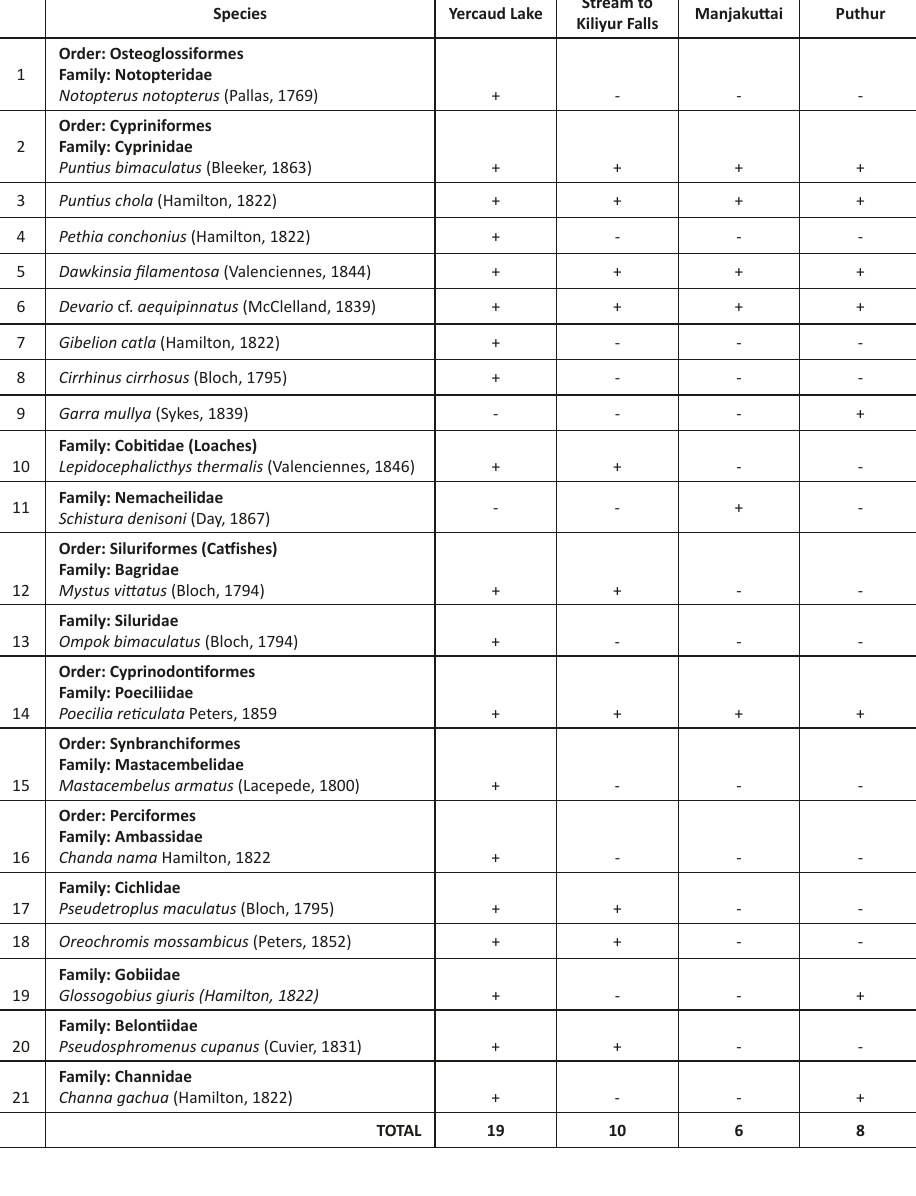
Table 1. Fishes of Yercaud